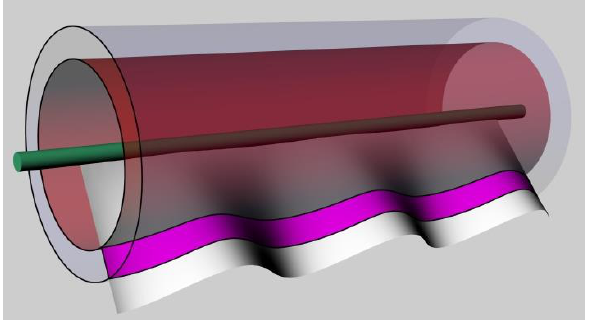
Figure 3: Rotation axis (green cylinder), distorted board (light grey surface) and cylinders (red and blue transparent) for the selection of points (pink